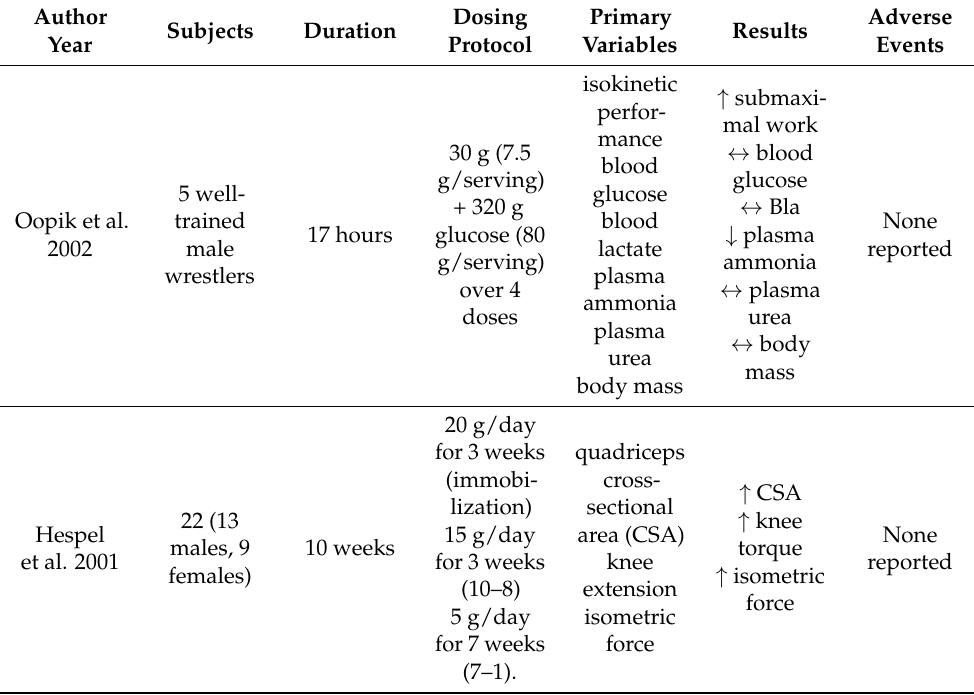
Table 7. Summary of selected studies examining the effects of creatine supplementation on indices of muscle damage, inflammation, and